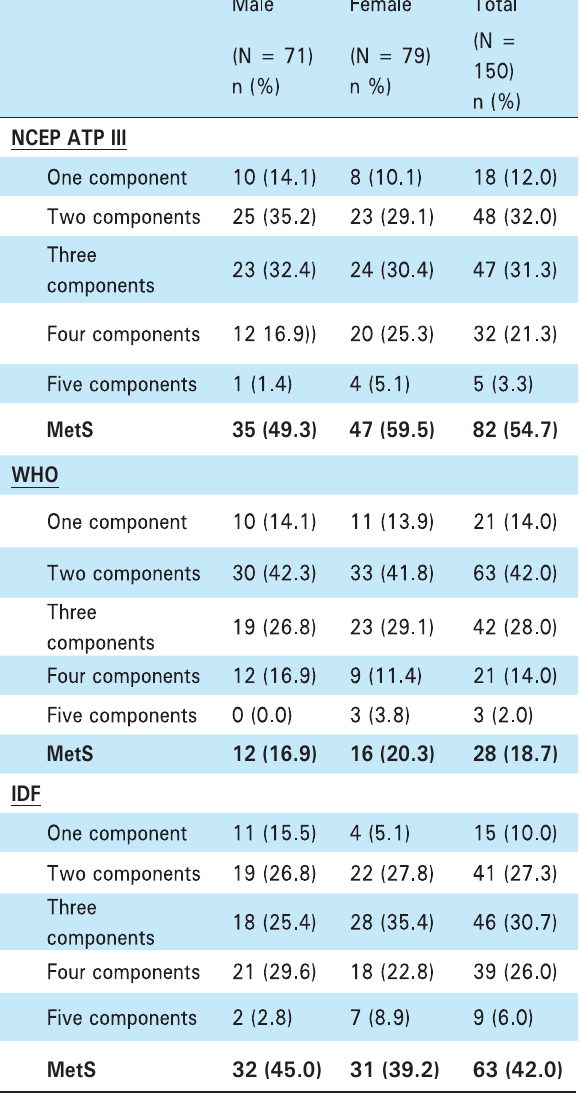
Table 1. Prevalence of the components of metabolic syndrome by three de fi nitions (NCEP-ATPIII, WHO and